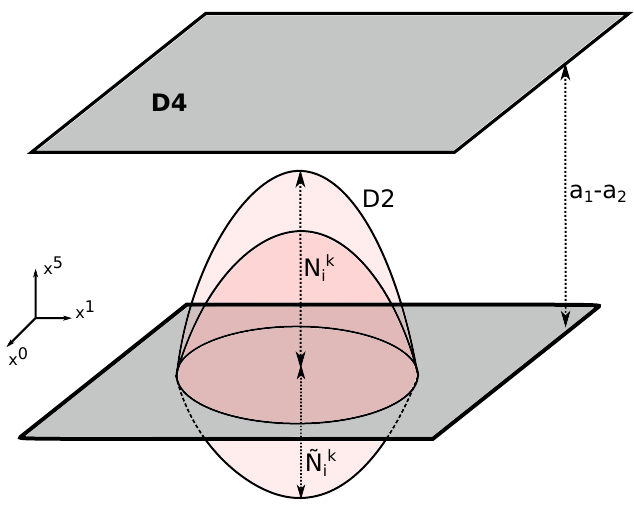
(cid:0) (cid:1) = " n k + 1 = 2 . For each i i (cid:0) (cid:1) n k + 1 = 2 i